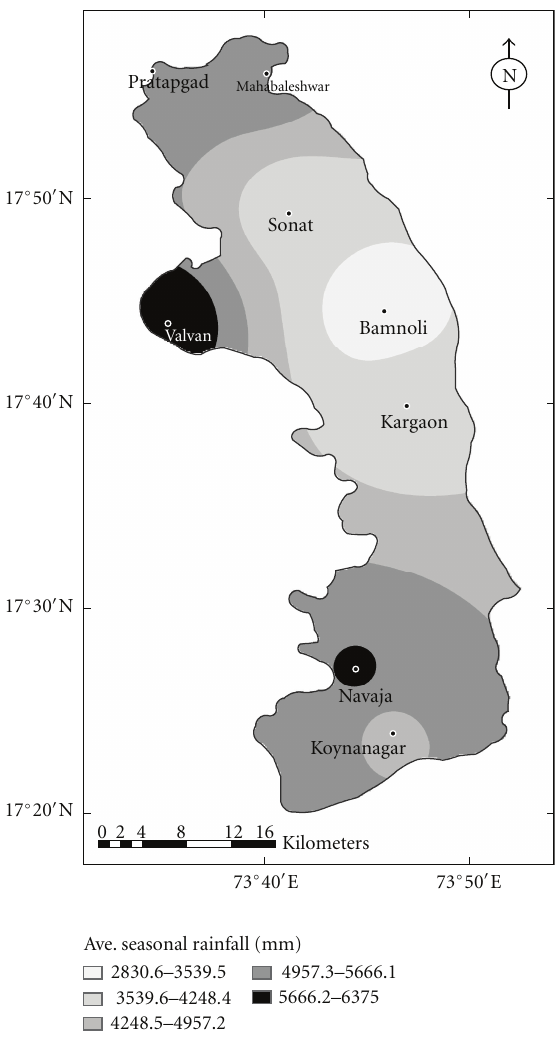
Figure 3: Spatial distribution of average seasonal rainfall (mm) over the Koyna